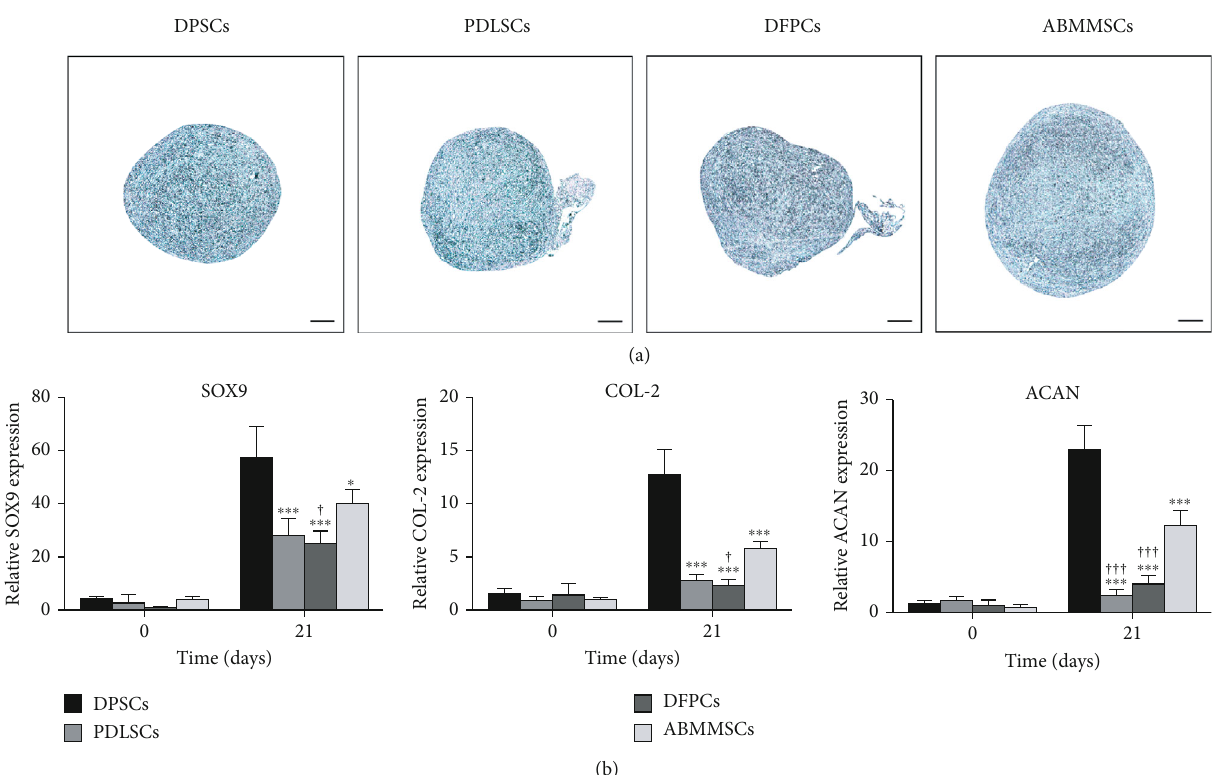
Figure 7: Chondrogenic di ff erentiation capacity of DPSCs, PDLSCs, DFPCs, and ABMMSCs. (a) Alcian blue staining of DPSCs, PDLSCs, DFPCs, and ABMMSCs after 21 days of chondrogenic di ff erentiation ( scale bar = 200 μ m). (b) qRT-PCR was performed to analyze the potency of chondrogenic di ff erentiation in DPSCs, PDLSCs, DFPCs, and ABMMSCs at days 0 and 21. The y -axis represents the relative mRNA fold change, which was calculated using the 2 − ΔΔ Ct formula with β -actin as the internal control. Error bars represent the SD ( n = 3 ) ( ∗ p < 0 : 05 , ∗∗ p < 0 : 01 , and ∗∗∗ p < 0 : 001 vs. DPSCs; # p < 0 : 05 , ## p < 0 : 01 , and ### p < 0 : 001 vs. PDLSCs; & p < 0 : 05 , && p < 0 : 01 , and &&& p < 0 : 001 vs. DFPCs; † p < 0 : 05 , †† p < 0 : 01 , and ††† p < 0 : 001 vs.